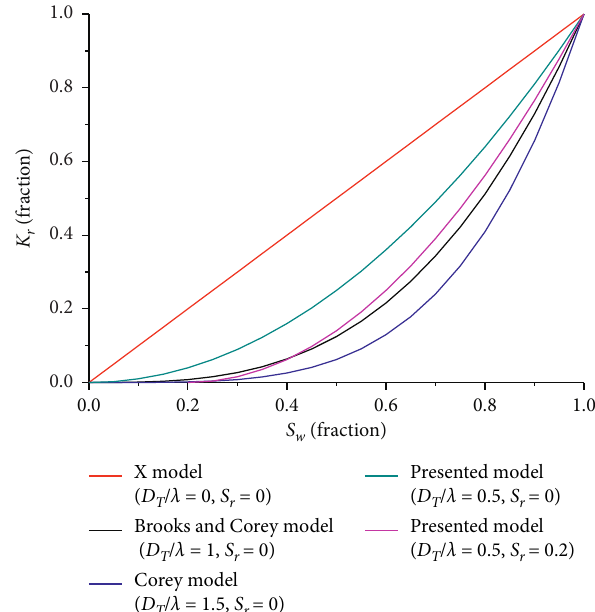
Figure 2: Relationships between relative permeability and satu- ration calculated from equation